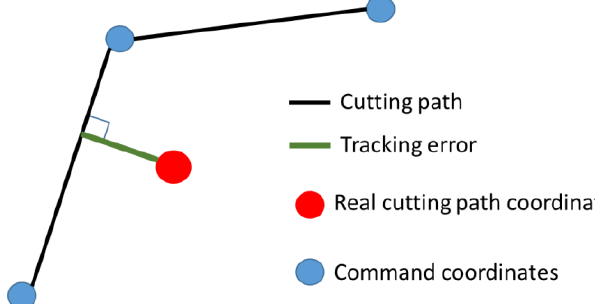
Figure 13. Theorical cutting path error calculation.